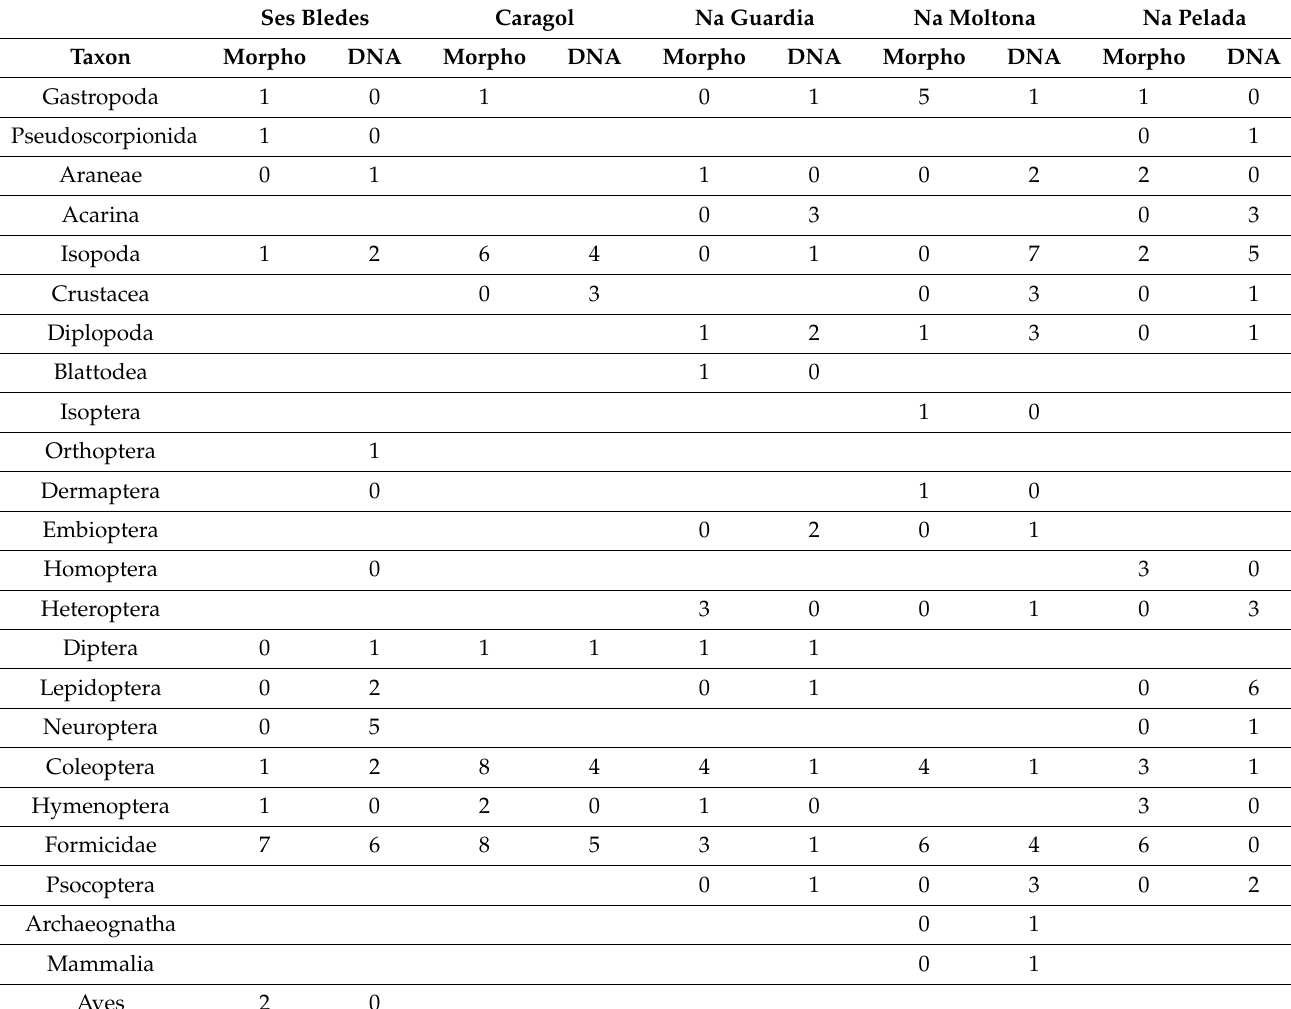
Table 2. List of the presence of identified diet taxa in morphological (morpho) and molecular analysis (DNA) of Podarcis lilfordi in the five populations under study. Taxa are grouped at the level of morphological identification (see more details in the